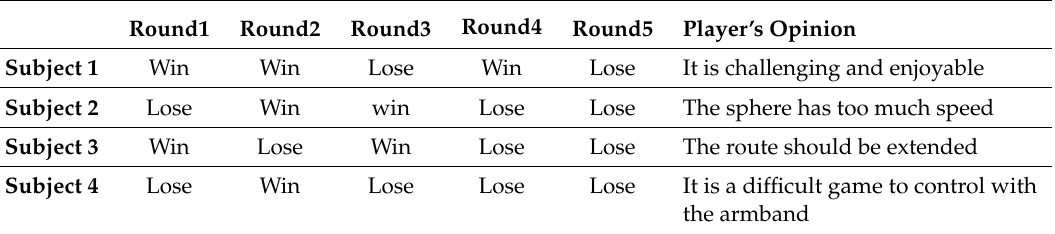
Table 1. Results for new subjects and their